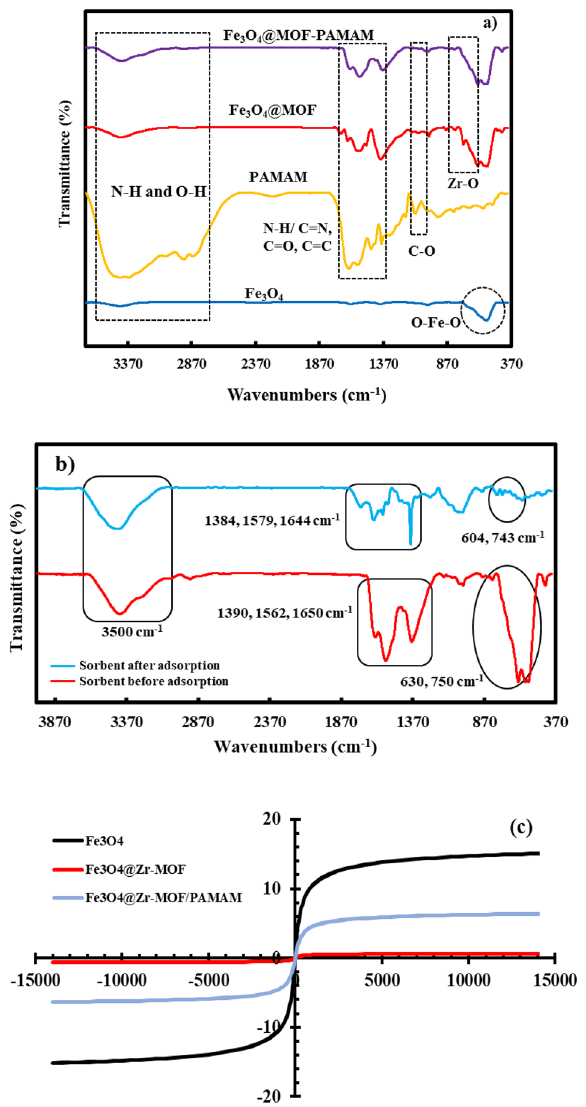
Figure 3. ( a ) FT-IR spectra of Fe 3 O 4, PAMAM, Fe 3 O 4 @MOF and Fe 3 O 4 @MOF-PAMAM; ( b ) FT-IR spectra of